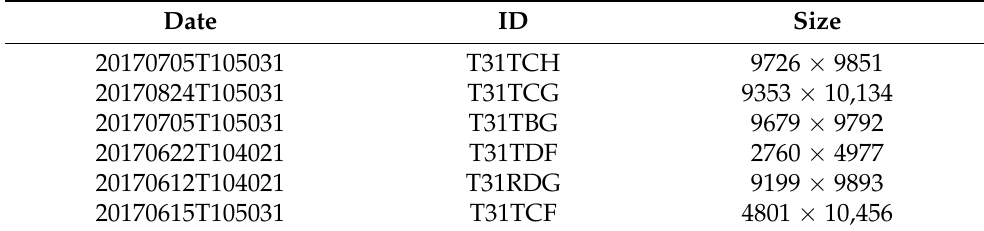
Table 1. S2GLC-Cat Sentinel-2 images downloaded from [63].